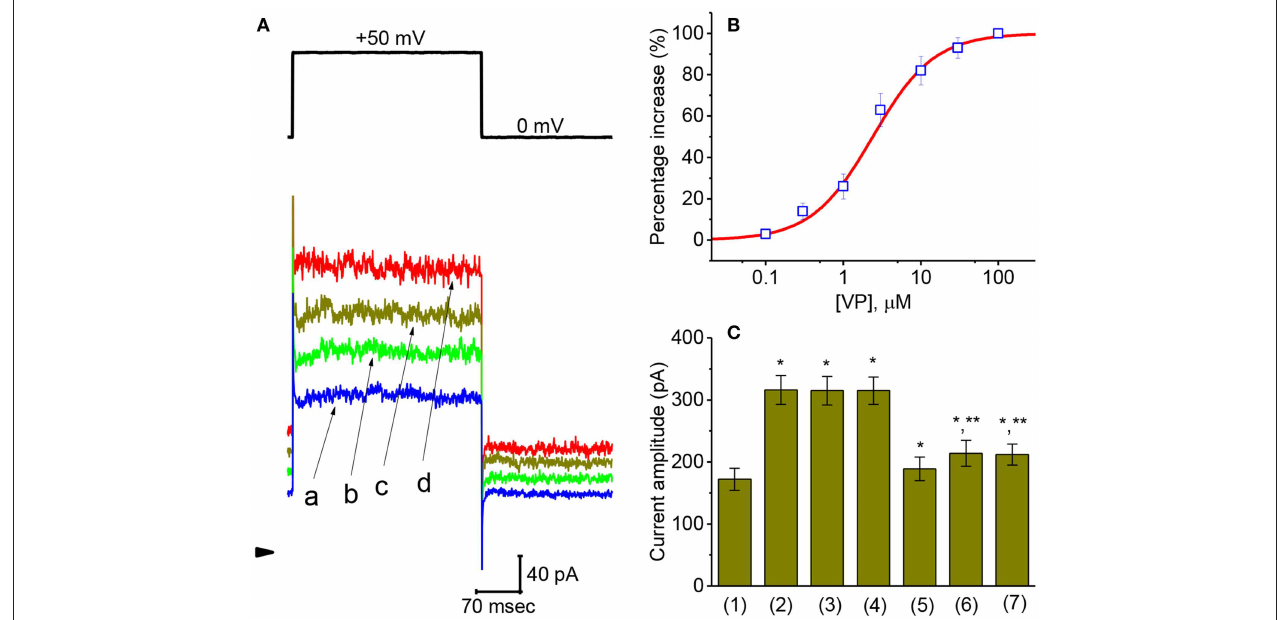
FIGURE 2 | Concentration-dependent effect of VP on I K(Ca) and the effects of different related compounds on VP-stimulated I K(Ca) in GH 3 cells. The experiments were conducted in cells bathed in normal Tyrode’s solution and the depolarizing pulse from 0 to + 50mV [indicated in the upper part of (A) ] was delivered to the